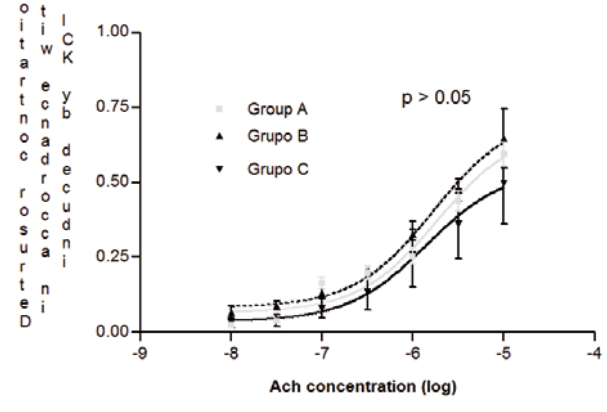
Group A: sham; Group B: obstructed; Group C: obstructed +